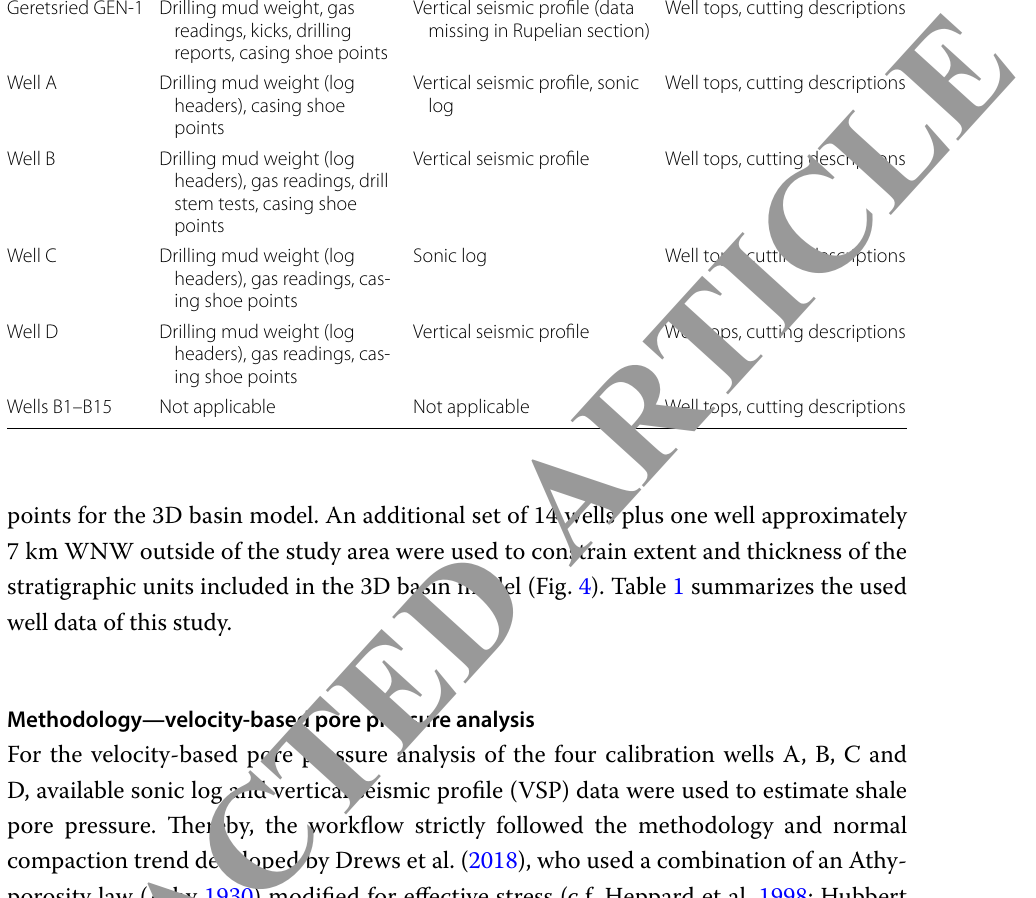
Table 1 Well data used in this study Well name Drilling